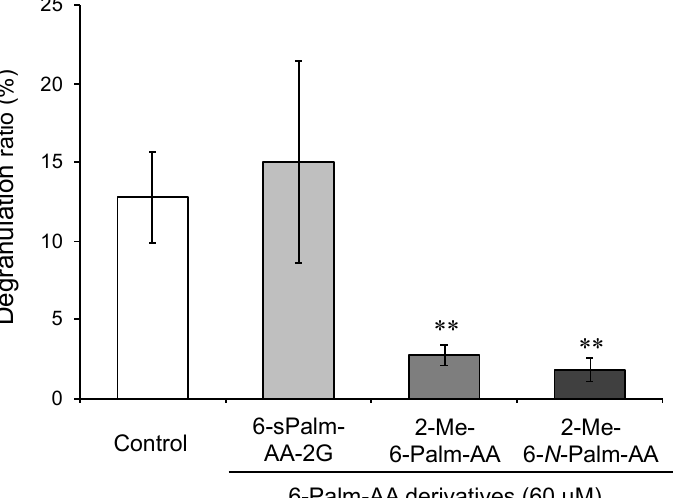
Figure 6. Inhibitory activities of 2-Me-6-Palm-AA and 2-Me-6- N -Palm-AA on calcium ionophore A23187-stimulated degranulation in RBL-2H3 cells. All data represent the means ± SD of three independent experiments. ** p < 0.01 (Dunnett’s test) as compared with the